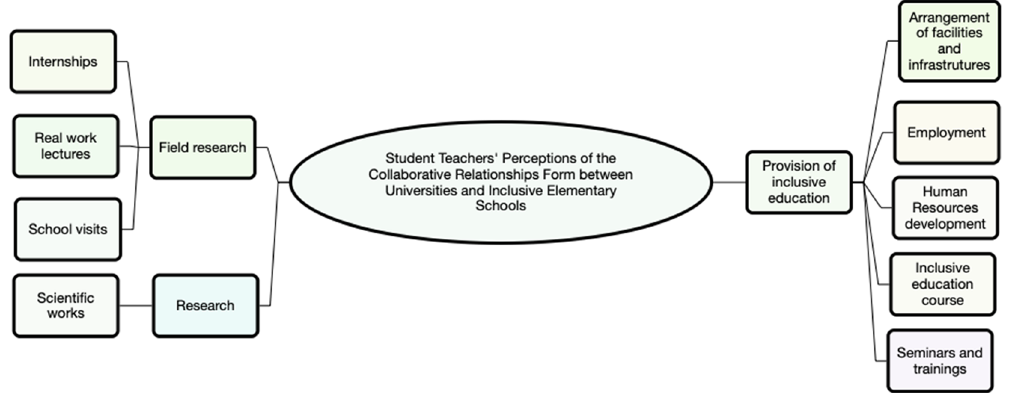
Figure 1. The main themes of thematic analysis (use Nvivo